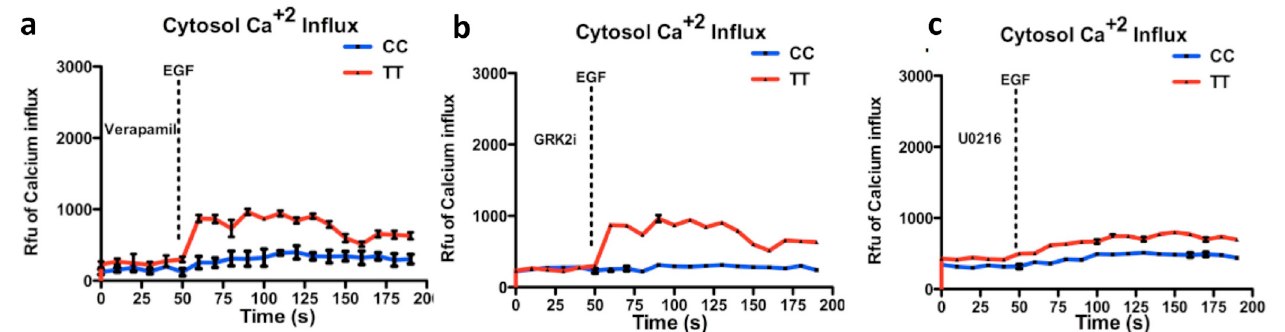
Figure 9. Cytosolic Ca 2+ influx in Gβ3s containing cells responds differently to growth signaling inhibitors. CC and TT cells were exposed to a co-treatment of Gβγ signaling inhibitors and EGF and in parallel, temporal changes in intracellular cytosolic Ca 2+ influx were quantified by employing Fluo-4 NW based Ca 2+ assay as mentioned in materials and methods. Treatments with calcium ion channel blocker Verapamil, G bg signaling inhibitor GRK2i, and MEK inhibitor U0216 caused decrease in EGF induced cytosolic Ca 2+ levels (a, b and c respectively) in both TT and CC lymphoblast cells, however, EGF induced Ca 2+ levels in TT lymphoblasts were more resistant to inhibitors than the CC counterparts. Inhibition of MAPK pathway by way of using MEK inhibitor U0216 was found to be most potent in inhibiting cytosolic Ca 2+ ions in TT lymphoblast cells. Data presented in all panels are the mean with a standard error (bars) of n = 3 independent experiments performed in octuplets. Statistical significance is shown as *P<0.05, **P<0.01,